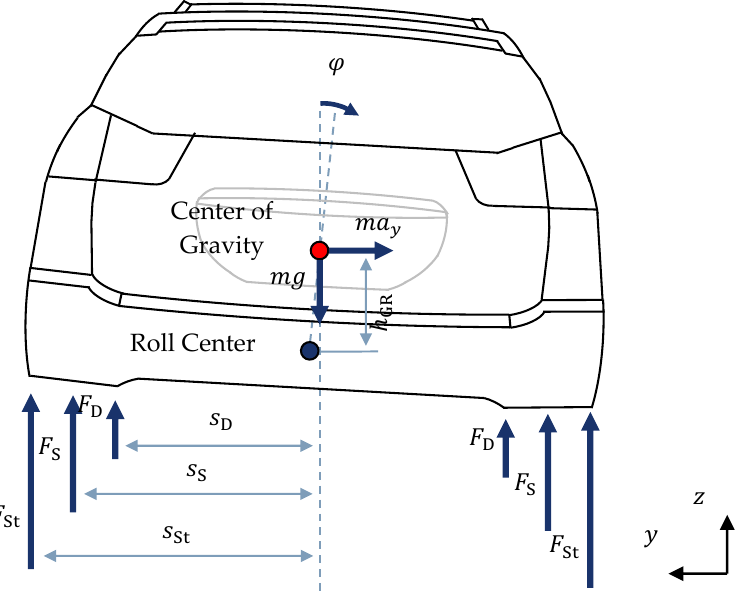
Figure 3. Free Cut of the Vehicle Body in the y-z Plane, cf. [16].